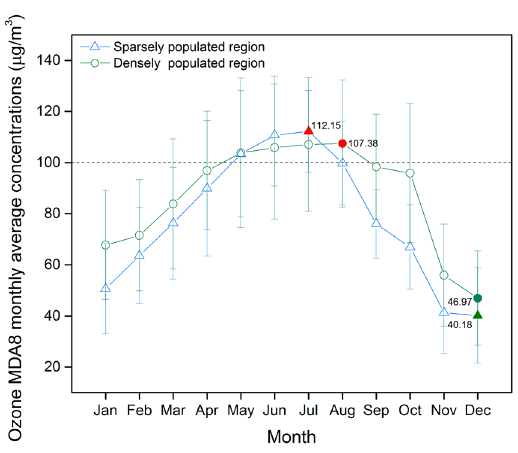
Figure 2. Monthly distribution of three-year averaged ground-level maximum daily 8-hour average (MDA8) ozone concentrations during